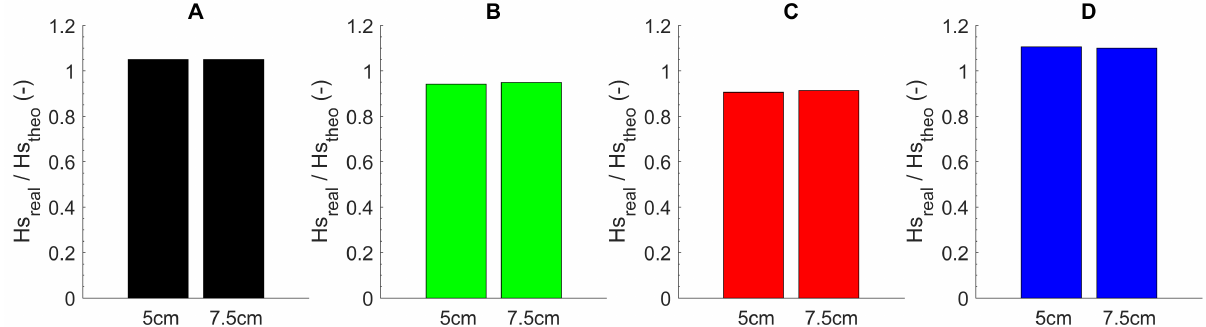
Figure 5. Ratio of realised ( H s and 7.5 cm sea-state for facilities ( A – D